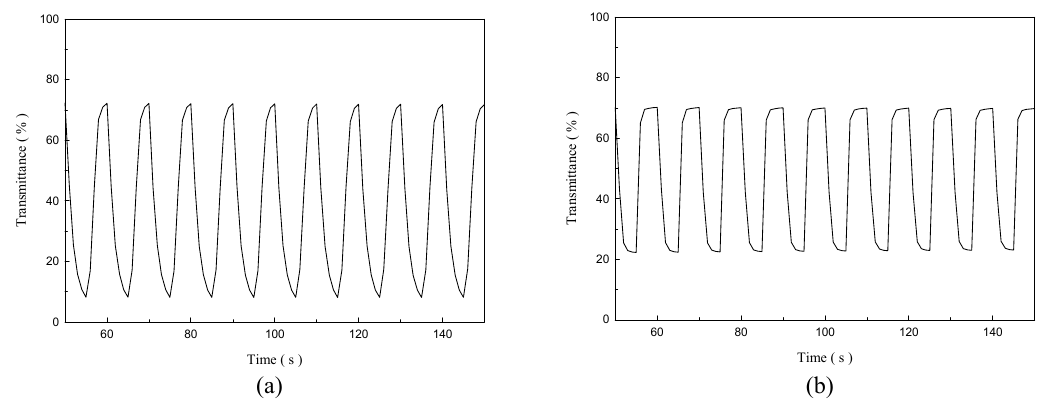
Figure 7. In situ transmittance of: ( a ) P(TTPA- co -DIT); and ( b ) P(TTPA- co -BDTA) films as a function of time in EPIDIL electrolyte, the time interval is 5 s. The copolymer films were prepared potentiostatically at 1.0 V on ITO electrodes and were stepped by repeated potential between 0.2 V and +1.2 V.